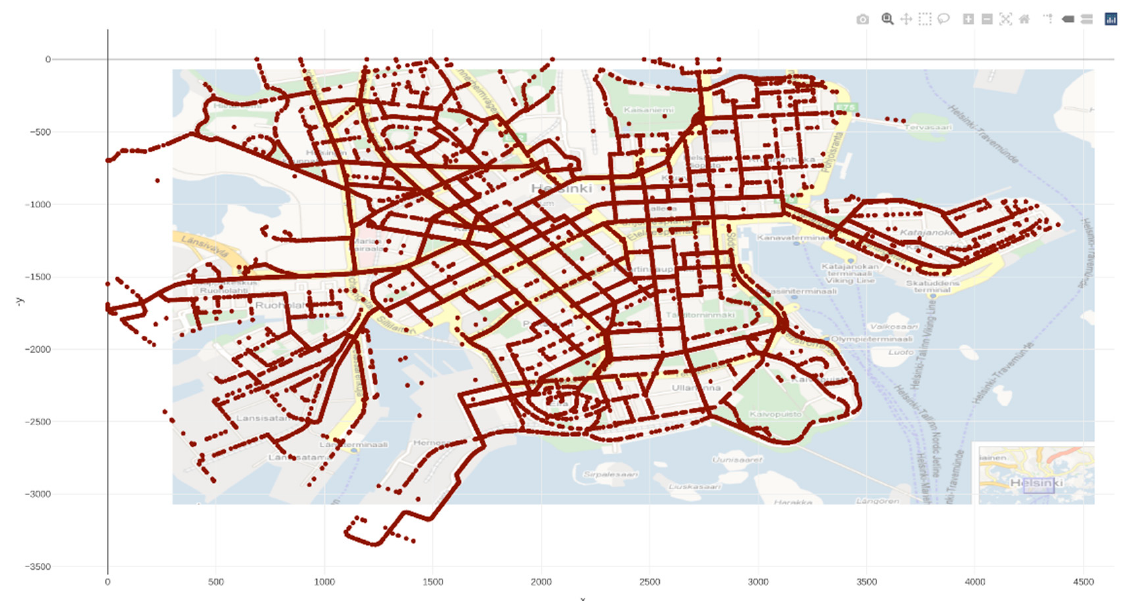
Figure 6. The coverage of the attacking vehicles throughout the attack time.